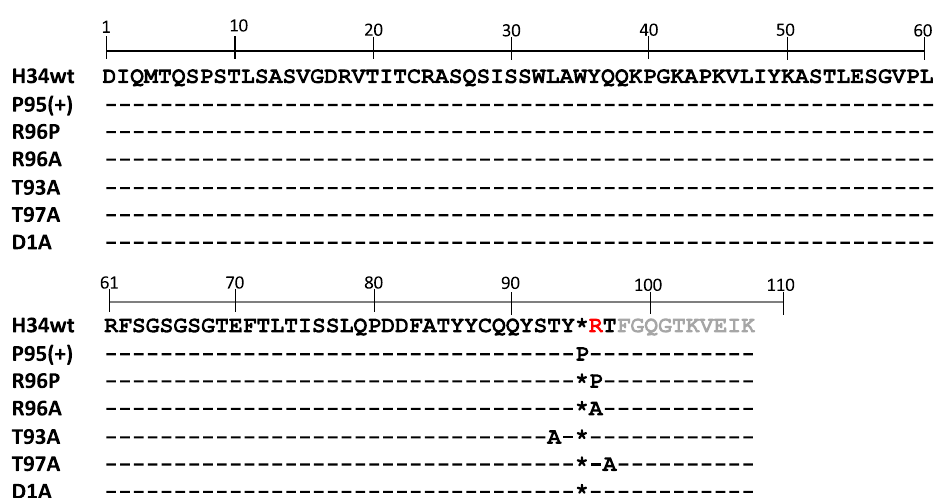
Figure 2. Amino acid sequences for H34wt and the mutants. The amino acid sequences of the variable region of H34wt and the mutants. There are no histidine residues in the variable region. Another feature of H34wt is the lack of Pro 95 , which is present in many antibodies. The amino acid residues considered to participate in the catalytic reaction are mutated to Pro or Ala. DNA sequences for H34wt and the mutants are deposited in DDBJ/ GenBank/EMBL (see Data availability